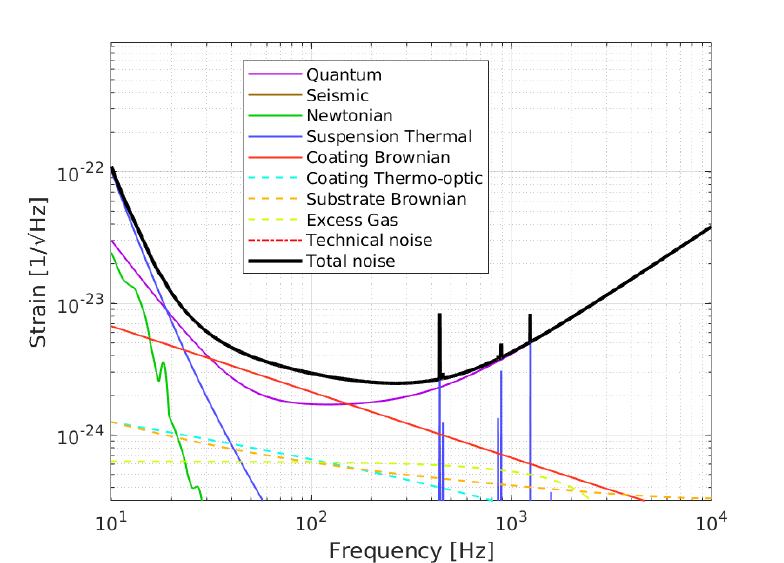
Figure 3. Example low (optimistic) sensitivity for O5, including breakdown into sub-component